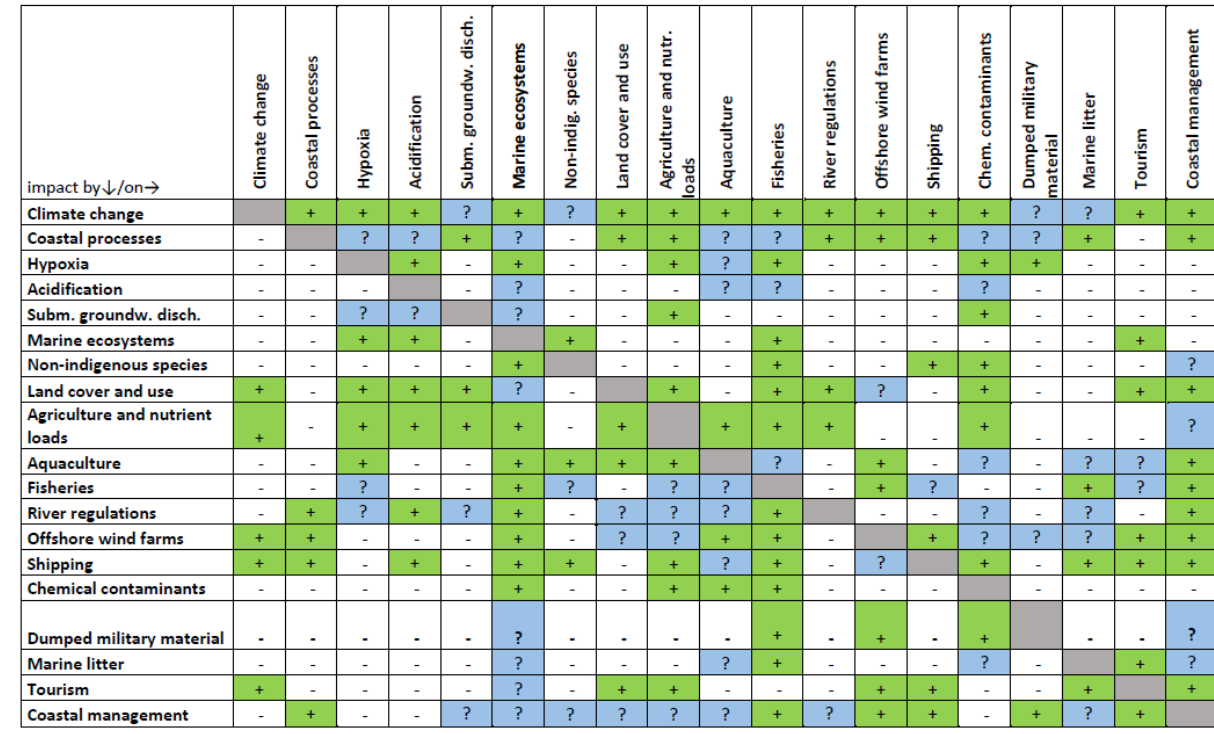
Table 1. The matrix of factors studied by Reckermann et al. (2022). + = evidence for a connection; − = no evidence for a connection; ? = no evidence but a connection is plausible (according to the author’s assessment). The table is read from left to right, i.e. if you go to the right in the first row “Climate change”, you see the factors on which climate change has an effect (or not), etc. (Source: Reckermann et al., 2022; their Table 2a distributed under the terms of the Creative Commons CC-BY 4.0 License, http://creativecommons.org/licenses/by/4.0/, last access: 4 February